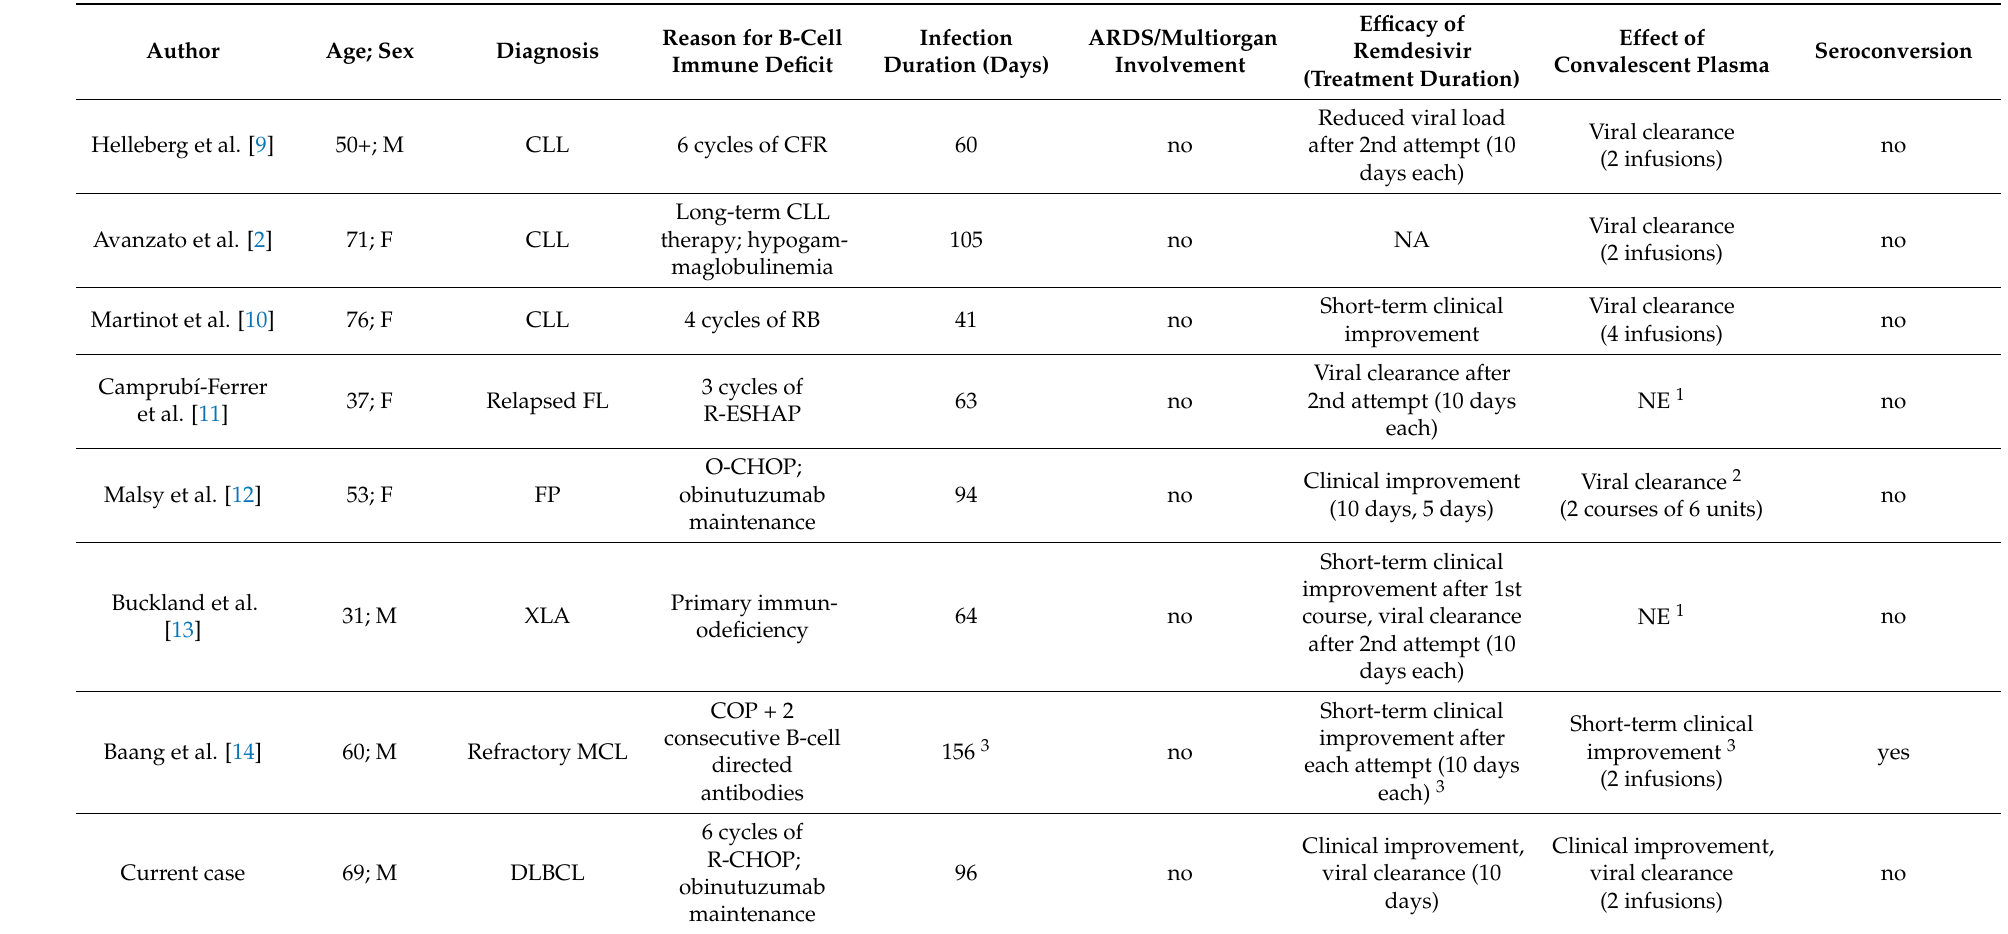
Table 1. Case reports of COVID-19 infection course in immunocompromised